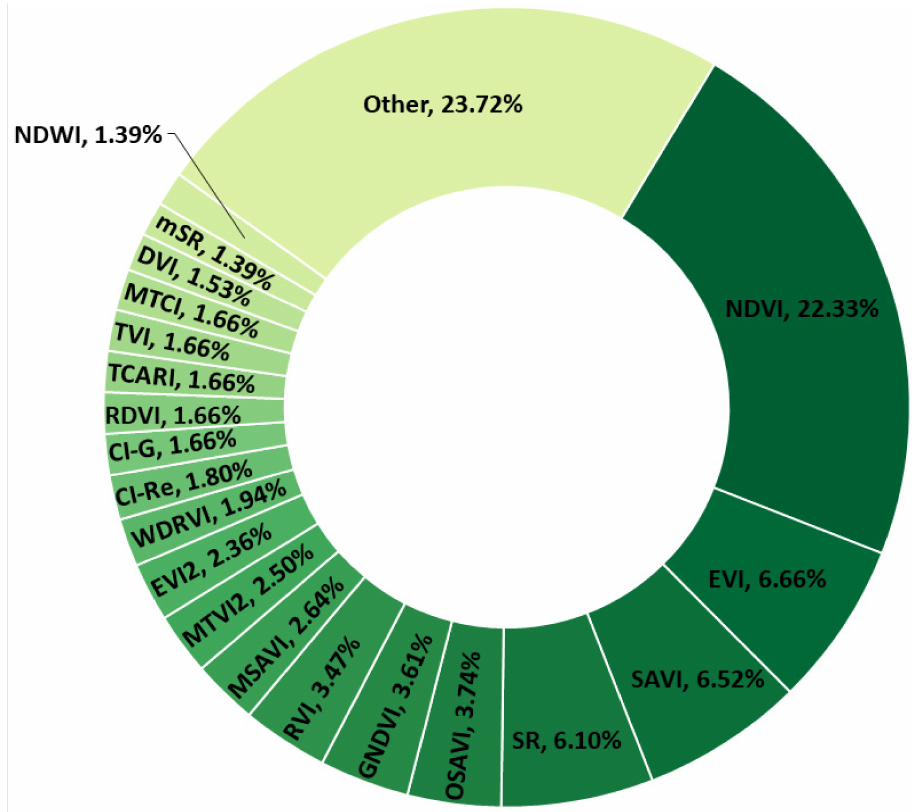
Figure 10. A representation of the most-utilized VIs. NDVI is simple to calculate from optical sensors carrying one red and one NIR band, and its meaning is intuitive to vegetation conditions [97]. Chlorophyll, an indicator of vegetation health, strongly absorbs energy in the visible region of the electromagnetic region; however, the cellular part of leaves strongly reflects the infrared light. When the plant becomes sick or afflicted with disease, it absorbs near-infrared light instead of reflecting it. Therefore, NDVI provides important information on chlorophyll content and is strongly correlated with plant health. Multispectral sensors are typically less costly to design, manufacture, and deploy than SAR sensors. Thus, multispectral sensors are attractive as payloads for spaceborne, airborne, and ground platforms [97]. For this reason, NDVI has been widely adopted for field-scale national and global monitoring. Many other VIs were studied in three or more manuscripts. These included the enhanced vegetation index (EVI) (48 papers), soil-adjusted vegetation index (SAVI) (47), simple ratio (SR) (44), optimized soil-adjusted vegetation index (OSAVI) (27), green NDVI (GNDVI) (26), ratio vegetation index (RVI) (25), modified soil-adjusted vegetation index (MSAVI) (19), modified triangular vegetation index 2 (MTVI2) (18), EVI2 (17), wide dynamic range vegetation